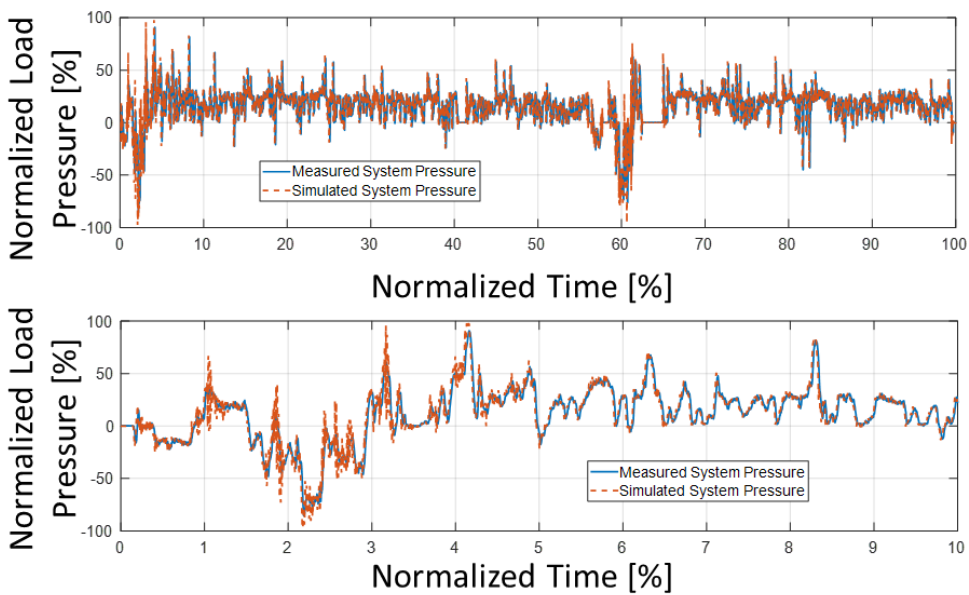
Figure 14. Measured vs. Simulated Normalized Load Pressure (Up is Full Drive Cycle; the lower image is Zoomed in for the First 10% of the